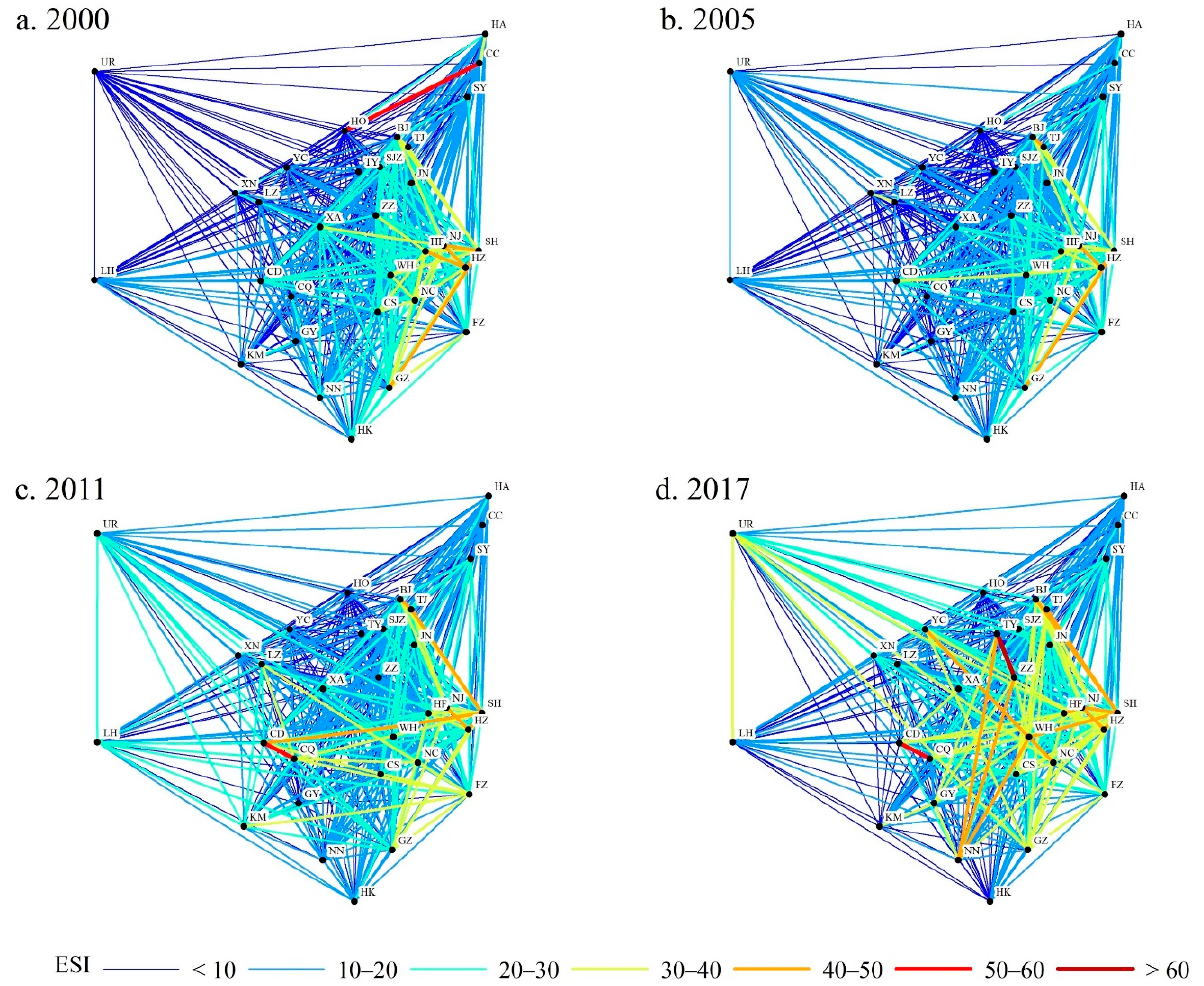
Figure 4. The ESI network between provincial capitals in 2000, 2005, 2011, and 2017. From a spatial perspective, we see high ESIs between provincial capitals in the south- east coastal area from an early date, gradually spreading to the central and western